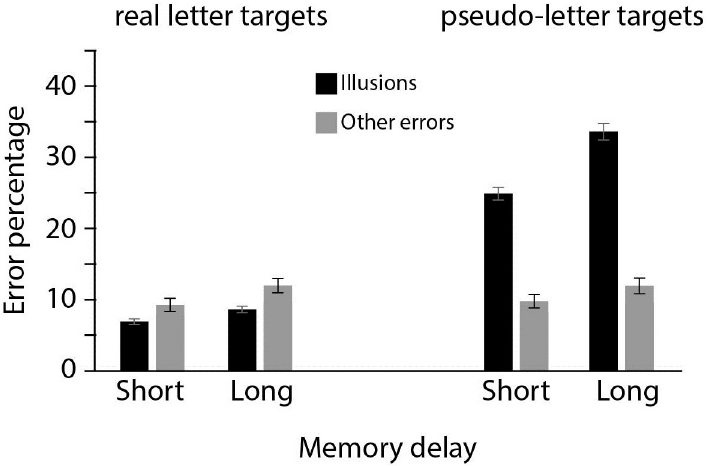
Fig 4. Experiment 2. Error rates in trials where participants indicated high confidence in their response. Percentages of expectation-induced errors and other errors are depicted for pseudo-letter targets (right display) or real letter targets (left display). All error rates are reported for the short and long Memory Delay conditions.